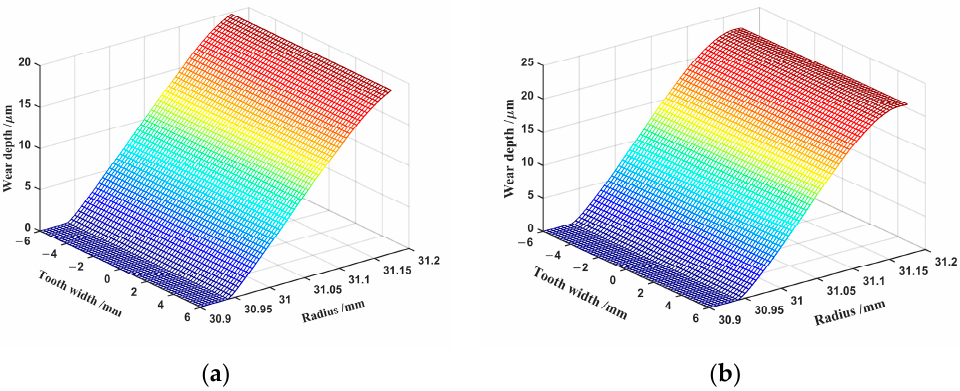
Figure 12. Wear depth: ( a ) double-arc tooth profile; ( b ) involute tooth profile.